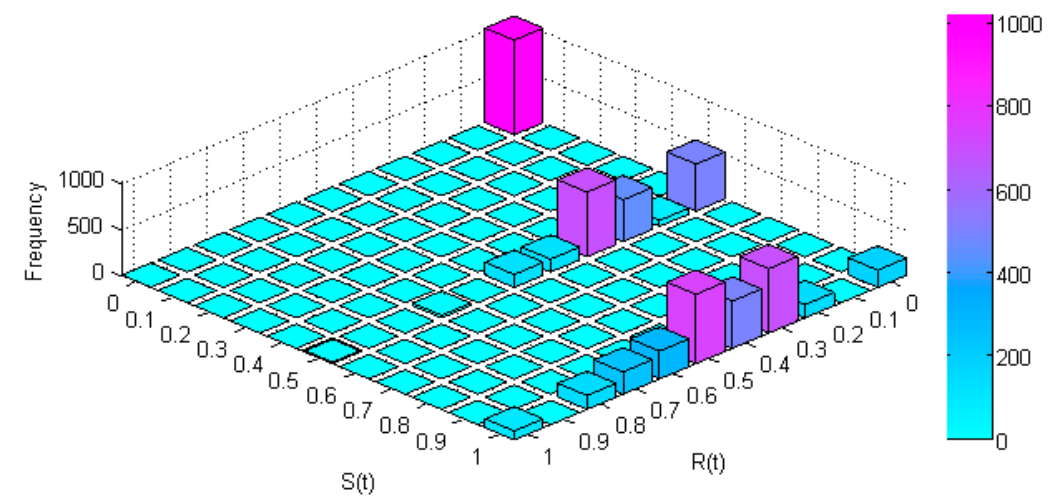
Figure 10. Relationship between R(t) and S(t) in a 3 × 3 PWMNS.